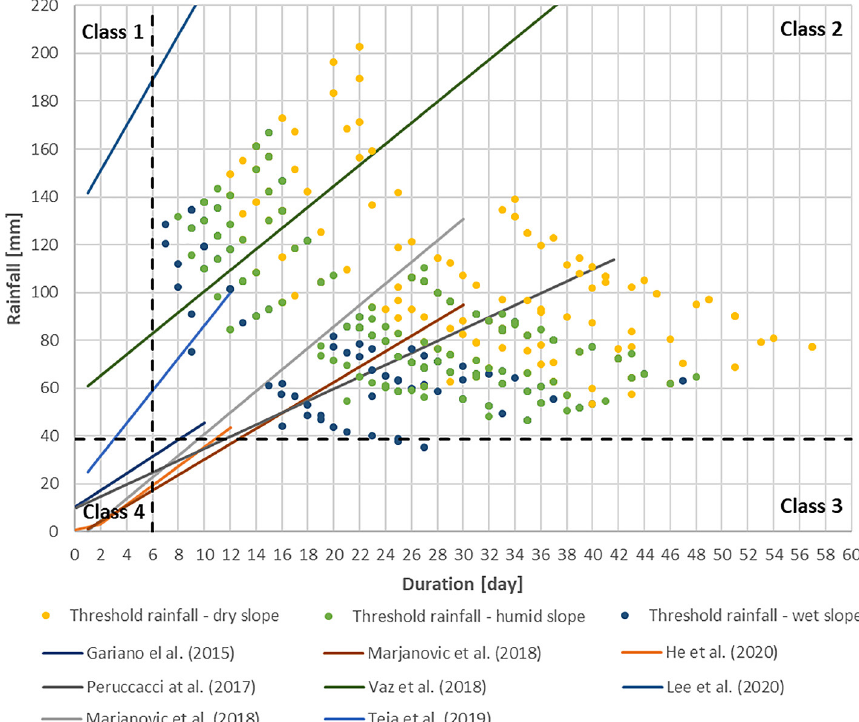
Fig. 14. Overview of the precipitation thresholds initiating landslides